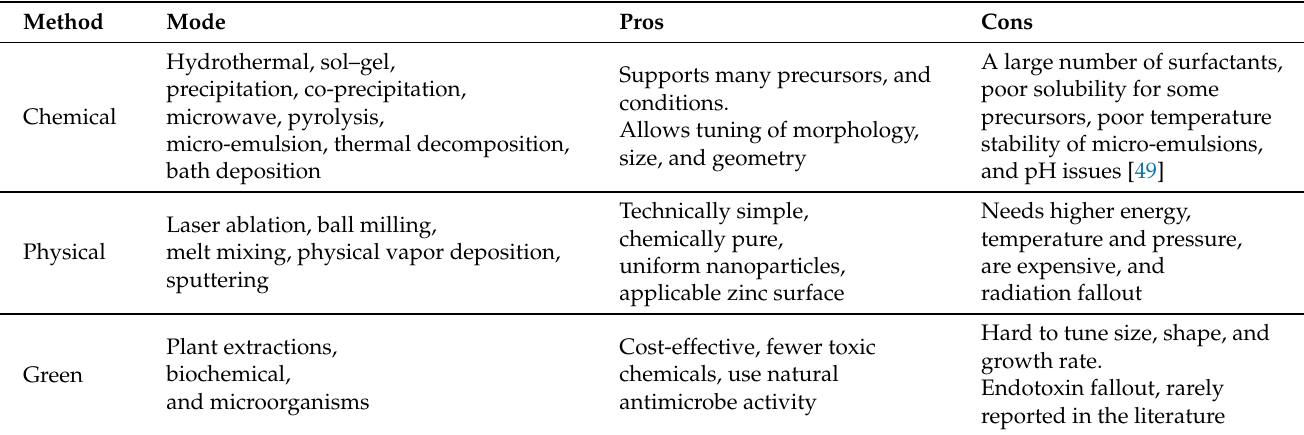
Table 2. A summary of the various synthesis methods, and their advantages and